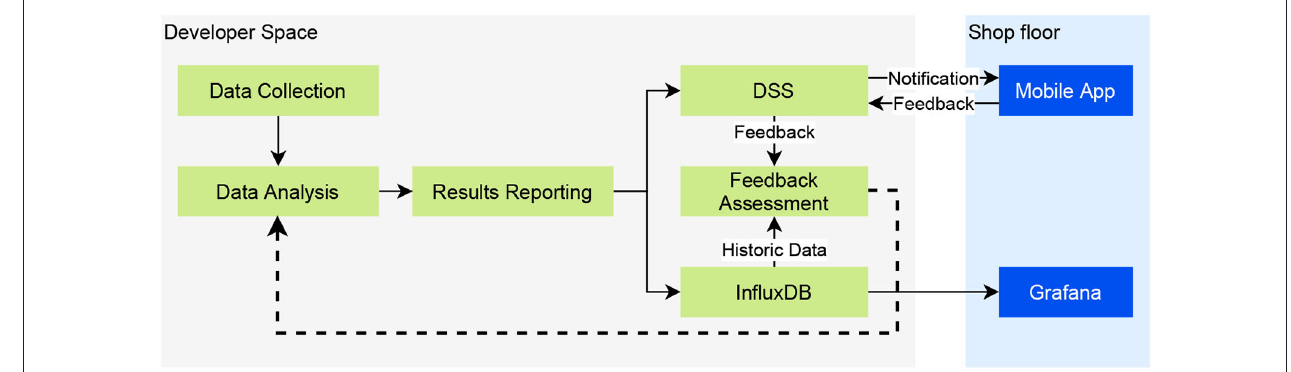
FIGURE 9 | Process integration